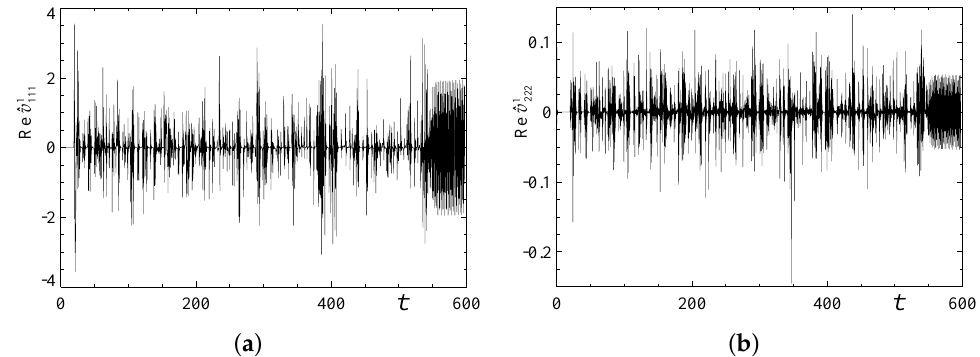
Figure 17. Temporal behaviour of the Fourier coefficients Re ˆ v 1 in run 3 x 1.2.